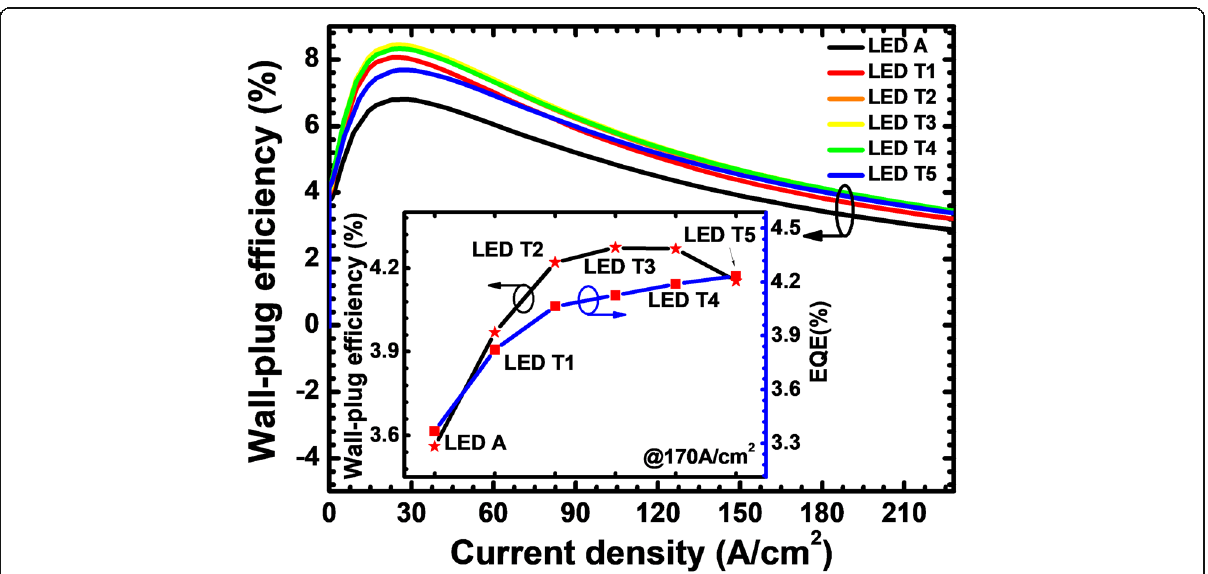
Fig. 8 WPE as a function of the injection current for LEDs A, T1, T2, T3, T4, and T5. Inset figure shows the WPE and EQE for the studied LEDs with various thicknesses of the n-Al